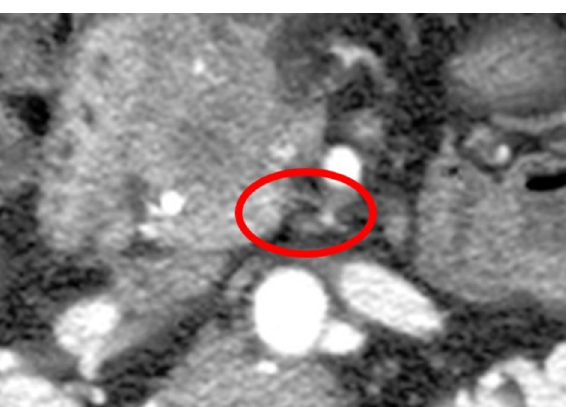
Figure 4. Axial CT scan in arterial phase shows Pattern 2 of EPNI, that represents infiltration along the IPDA in the reticular pattern without tumor